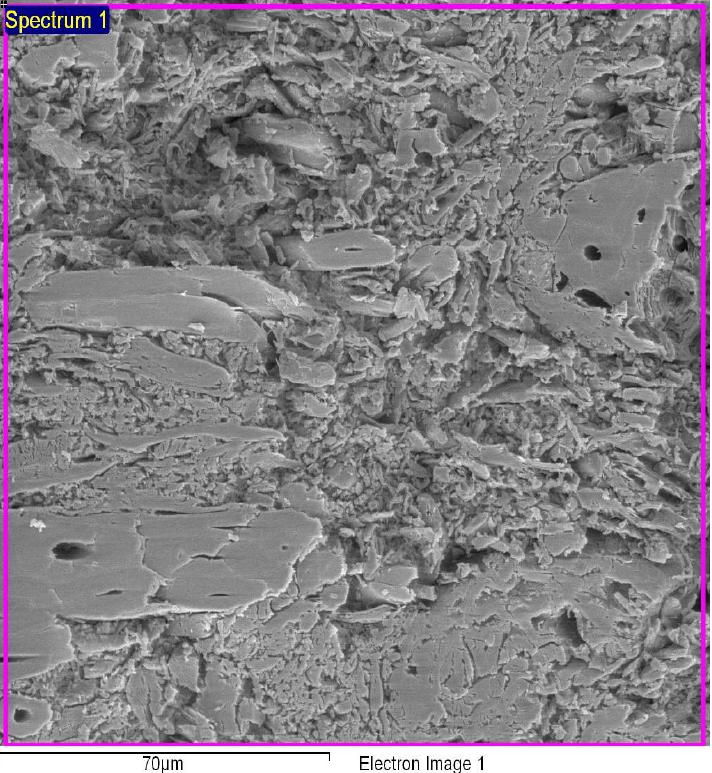
Figure 7. Micrograph of Rhizophora spp. particleboard bonded with 0% binder.